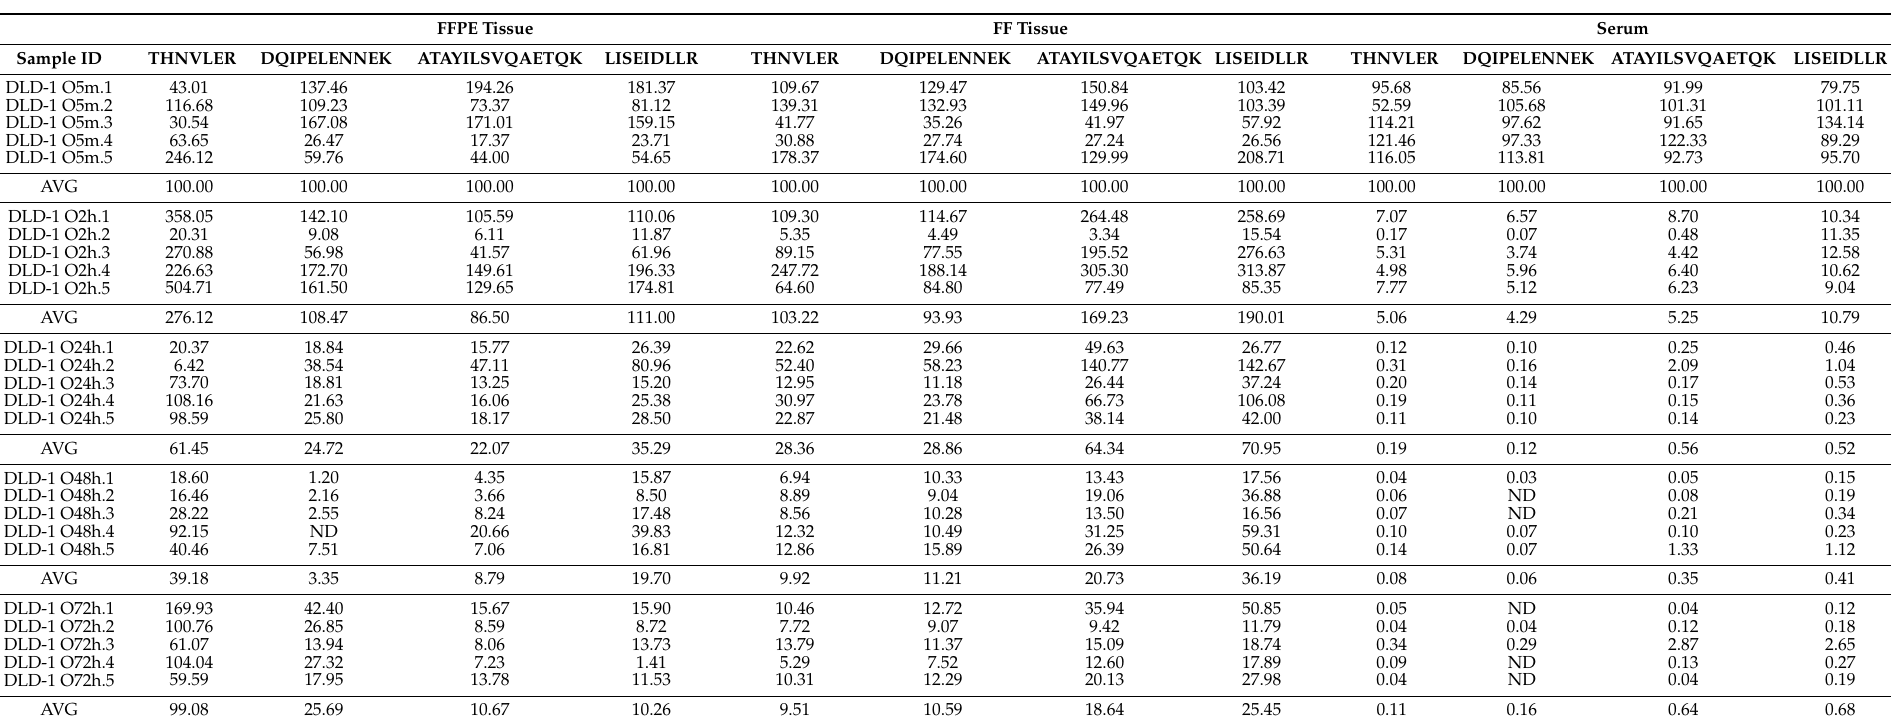
Table 1. Remaining percentage of Omomyc per sample relative to the earliest timepoint (5 min). Each absolute quantification of Omomyc in different samples